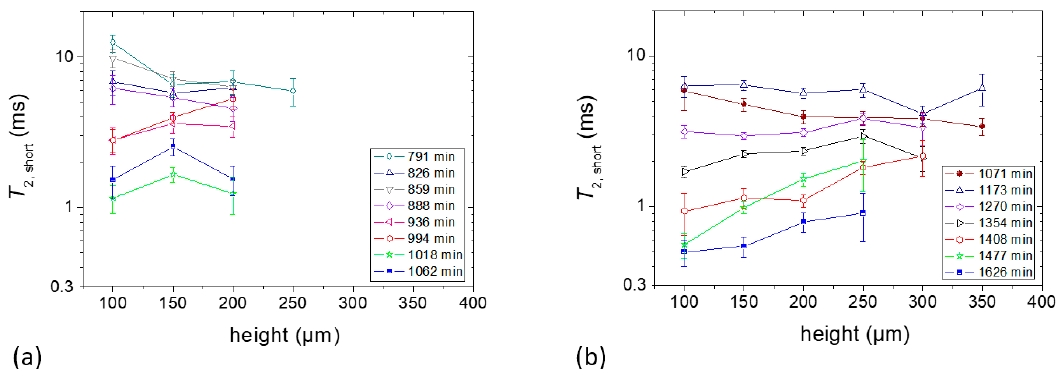
Figure 6. T 2 values of the fast decaying components at di ff erent heights of the sample. ( a ) Sample c containing 1% starch in H 2 O ( w / v ) and ( b ) Sample d containing 5% starch in H 2 O ( w / v ). Each sample contained glycerol (20 g / 100 g of starch) as a plasticizer. Layer positions correspond to coordinates introduced in Figure